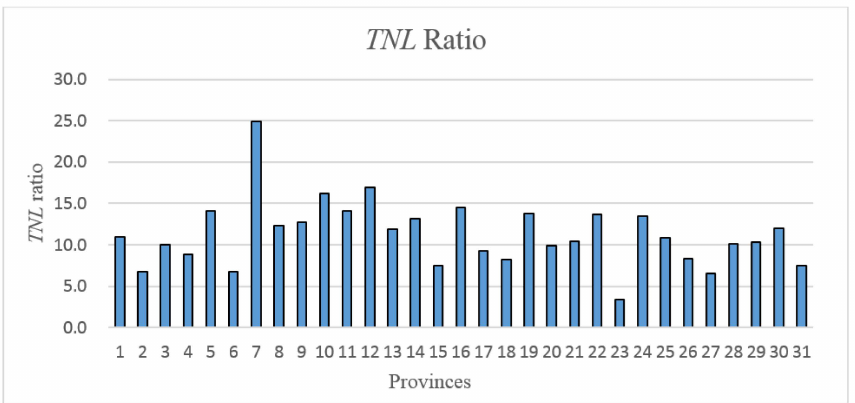
Figure 9. TNL ratio between saturation-corrected DMSP stable data and quantized DNB composite data for 31 provinces in China. Names corresponding to the indices of these provincial regions are listed in Table A1. Mean ratio = 11.28 and standard deviation of the ratio =